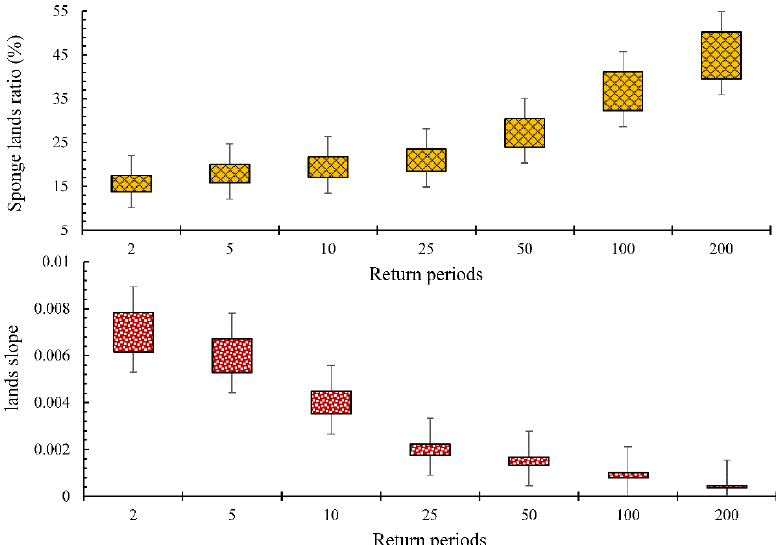
Figure 2. Sponge lands and design slope for different return periods.